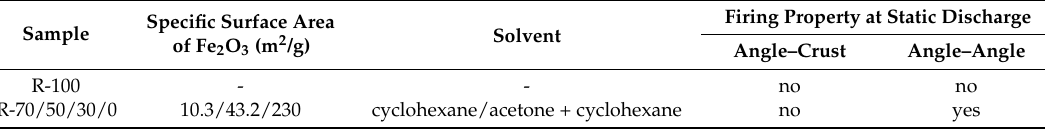
Table 4. Static discharge safety properties of Al/Fe 2 O 3 /RDX nanocomposites in an electric